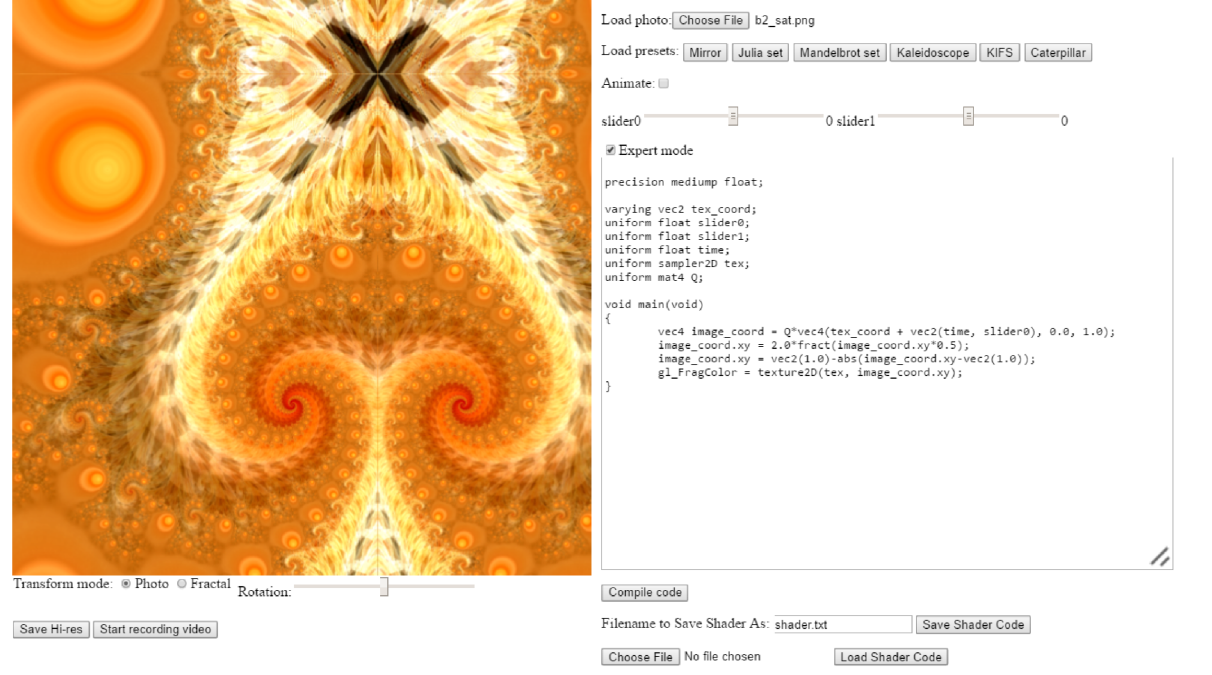
Figure 3 | Screenshot of PhotoFrac for the